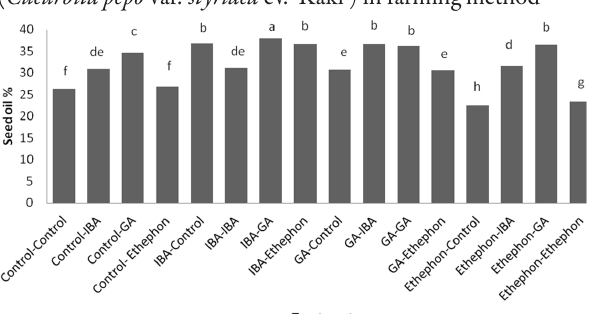
Fig. 1. Effect of PGRs on seed yield kg/ha in medicinal pumpkin ( Cucurbita pepo var . styriaca cv. ‘Kaki’) in farming method